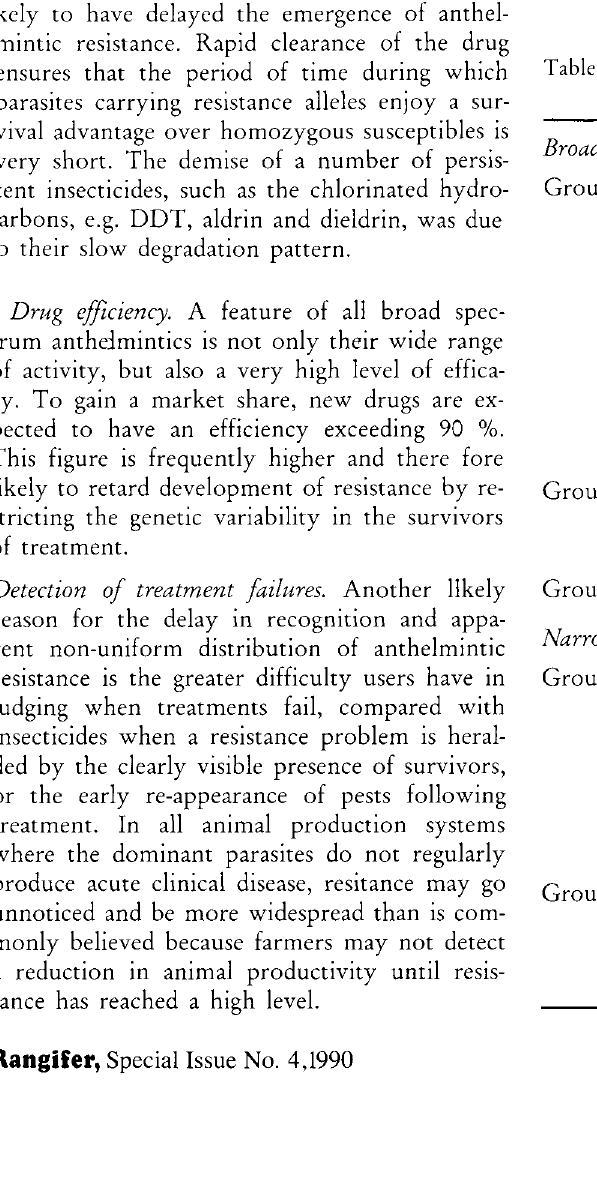
Table 1. Commonly available anthelmintics for ne matode control in